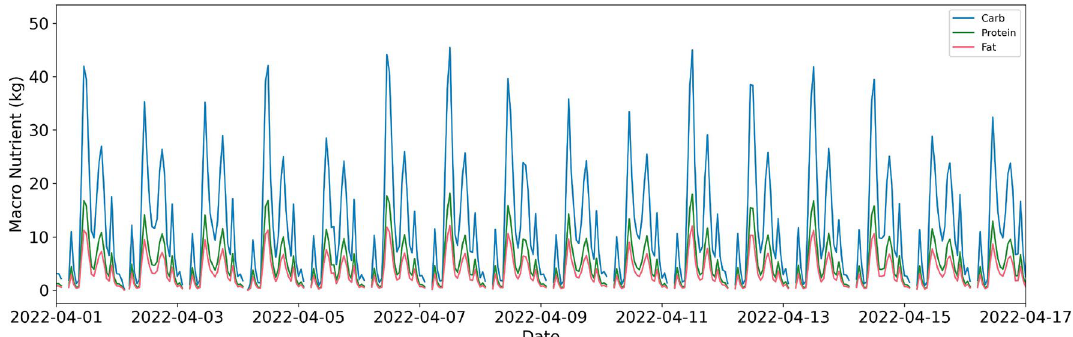
Figure 7. The macronutrient forecast on an hourly basis for the period between April 01 and April 17, 2022 (inclusive) based on the number of dining covers recorded. Each point represents the typical amount (in kg) of a particular macronutrient needed to meet the basic nutritional needs of staff members for that given